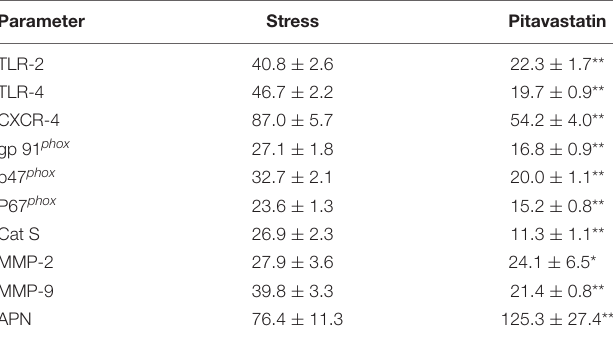
TABLE 5 | Real-time PCR analysis of the targeted genes in the aortic roots and APN in subcutaneous fat of both experimental group mice. Parameter Stress